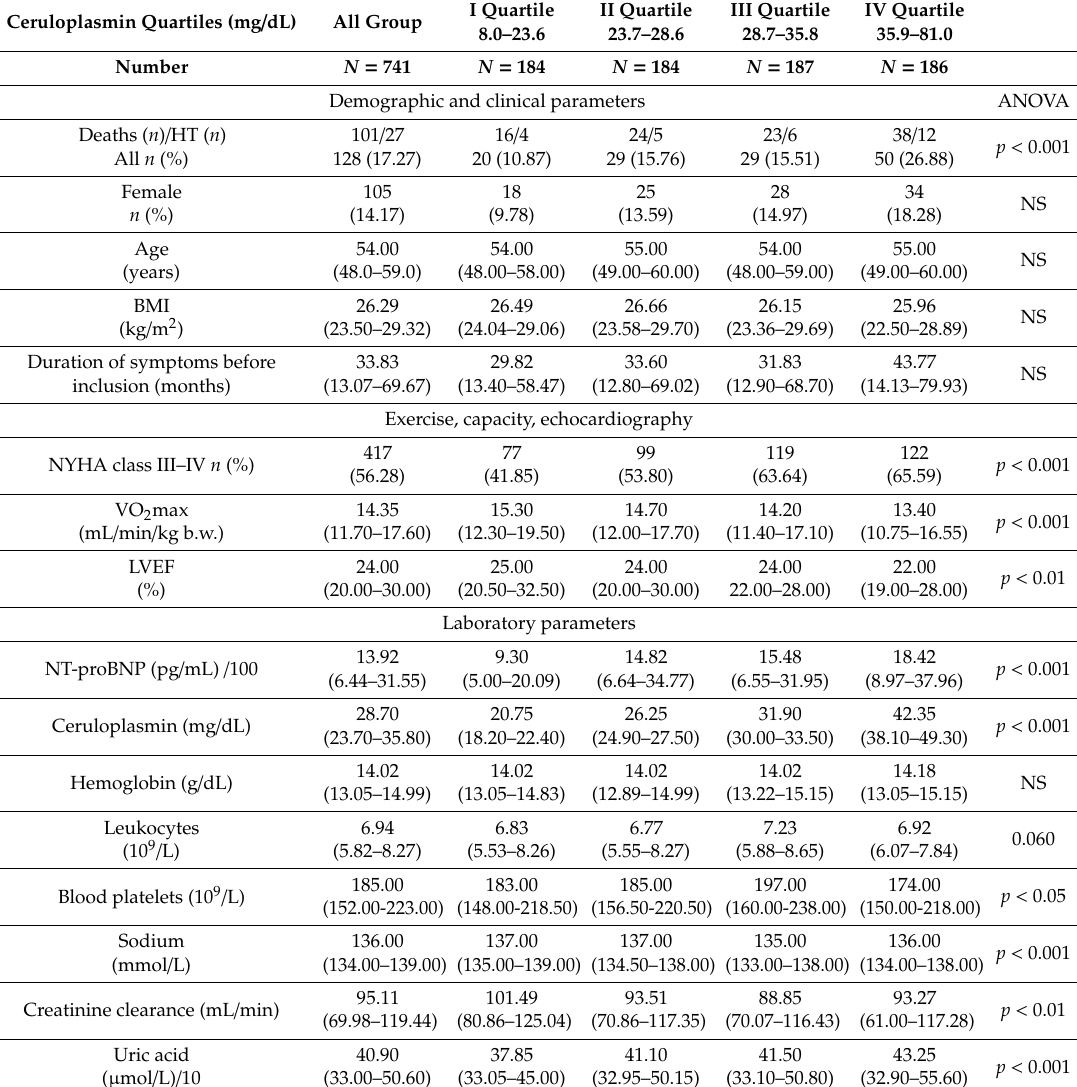
Characteristic of the examined group with division according to ceruloplasmin concentration